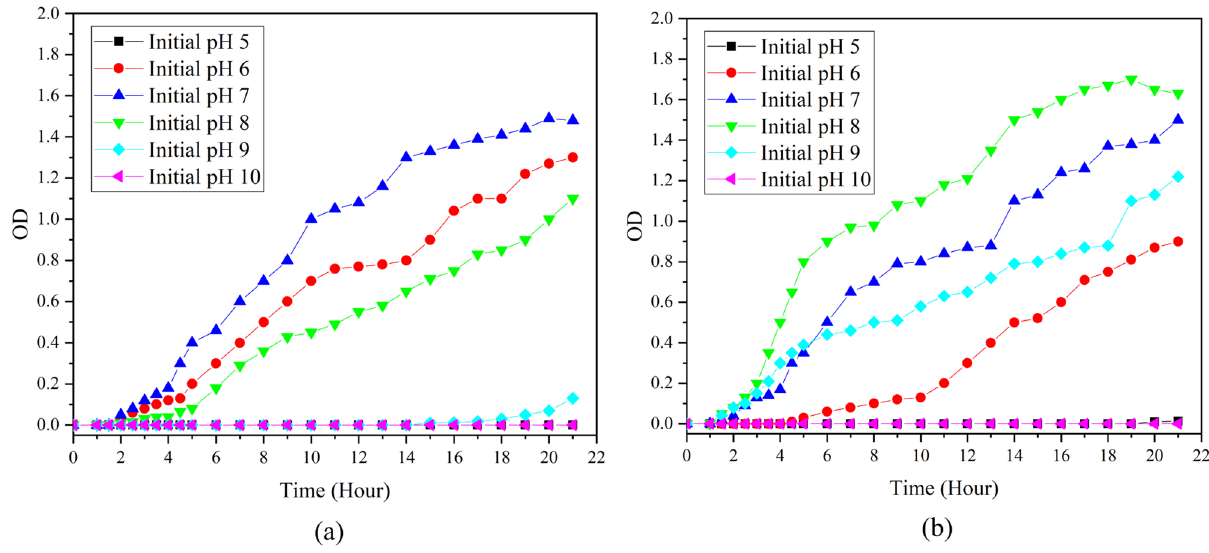
Figure 5. Growth curves of ( a ) Bacillus amyloliquefaciens ( b ) Bacillus subtilis, at different initial culture medium pH values.